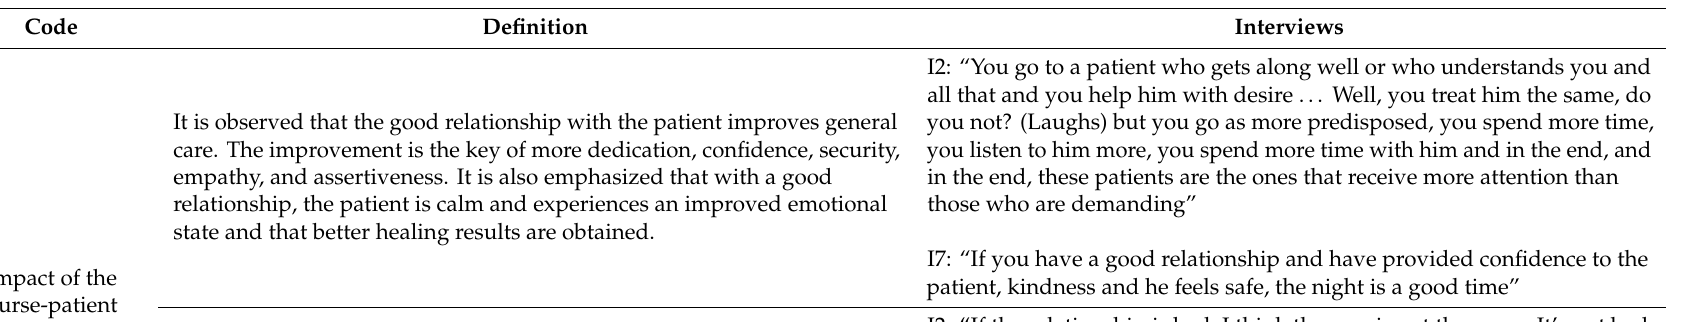
Category: Patient as a Passive Object of